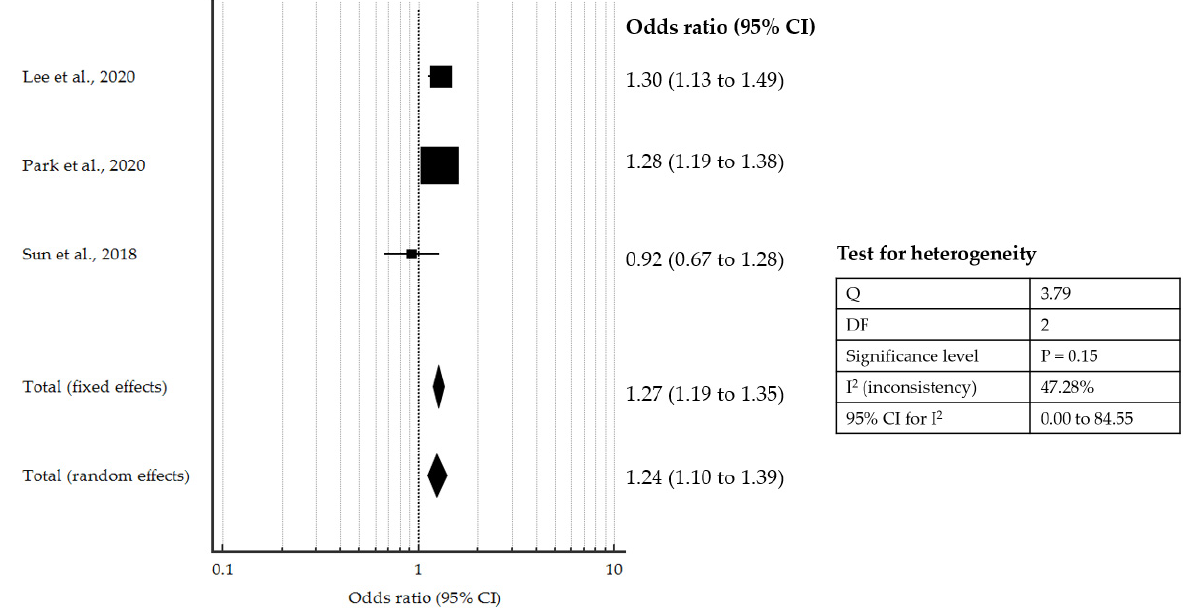
Figure 4. Forest plot showing pooled OR for good neurological outcomes with HP CPR or similar intervention compared to controls [14,20,21].